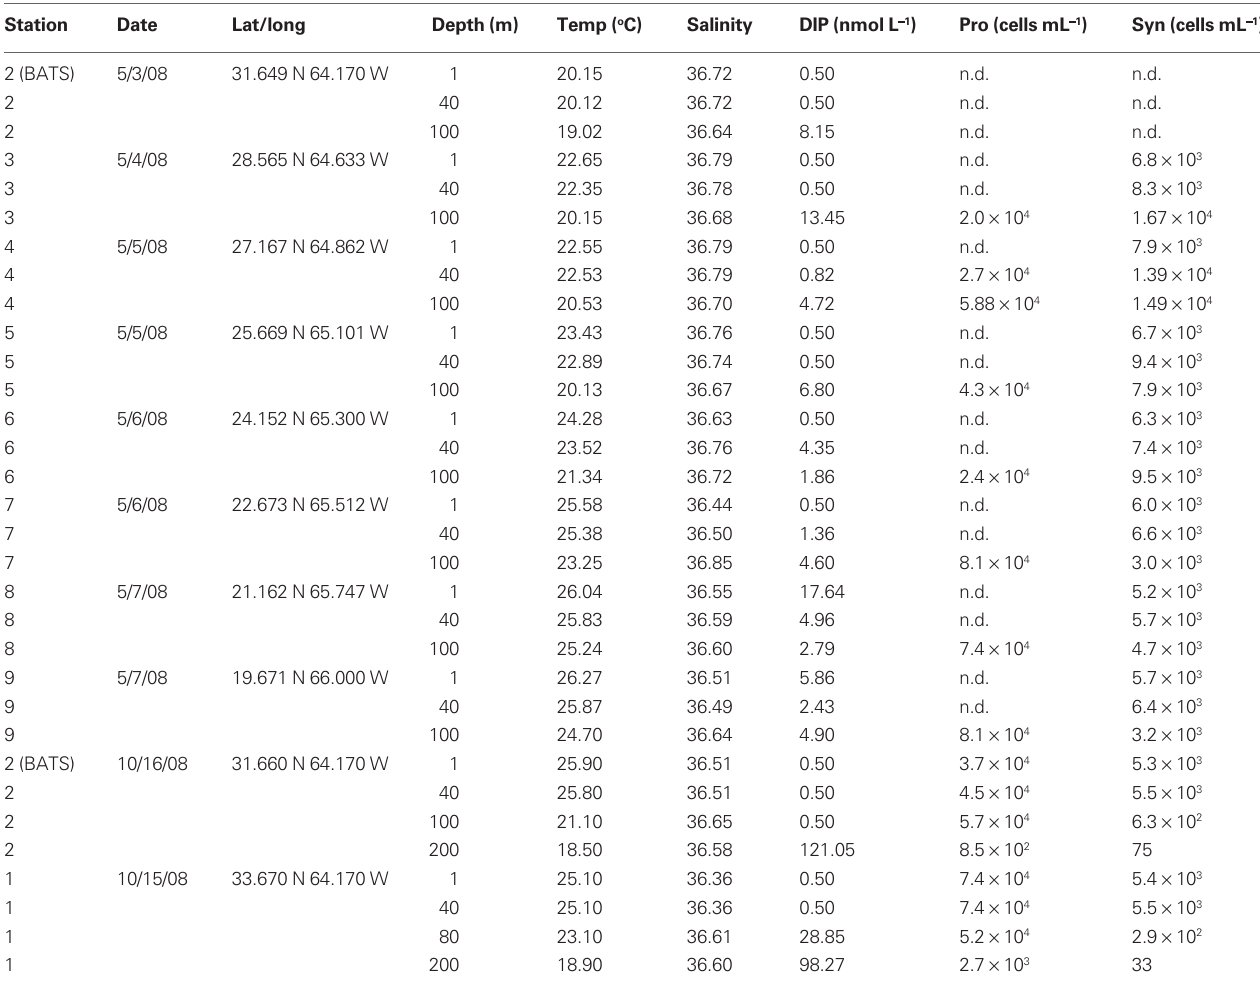
Table 1 | Summary of samples obtained during May and October 2008 cruises.